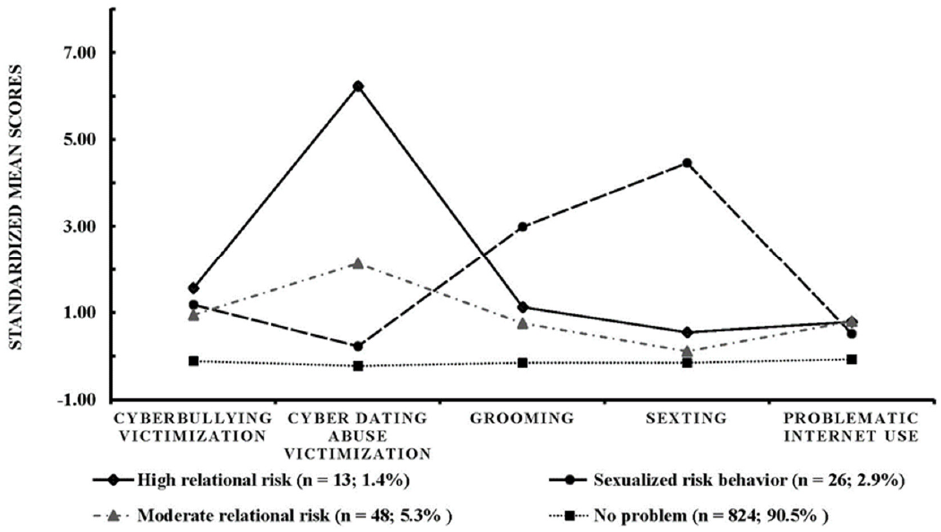
Figure 1. Classes resulting from the latent profile analysis (standardized scores).